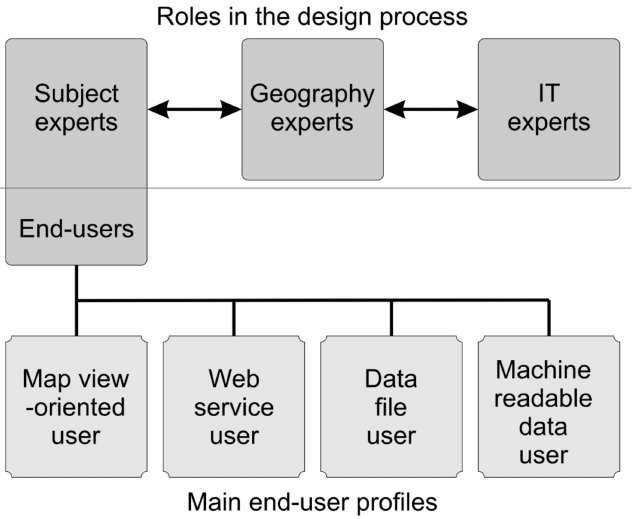
Figure 3. Roles and main communication routes in the design process of a multidisciplinary spatial data platform, and main end-user profiles. End-users can have a dual role in the process, as subject experts and users of the